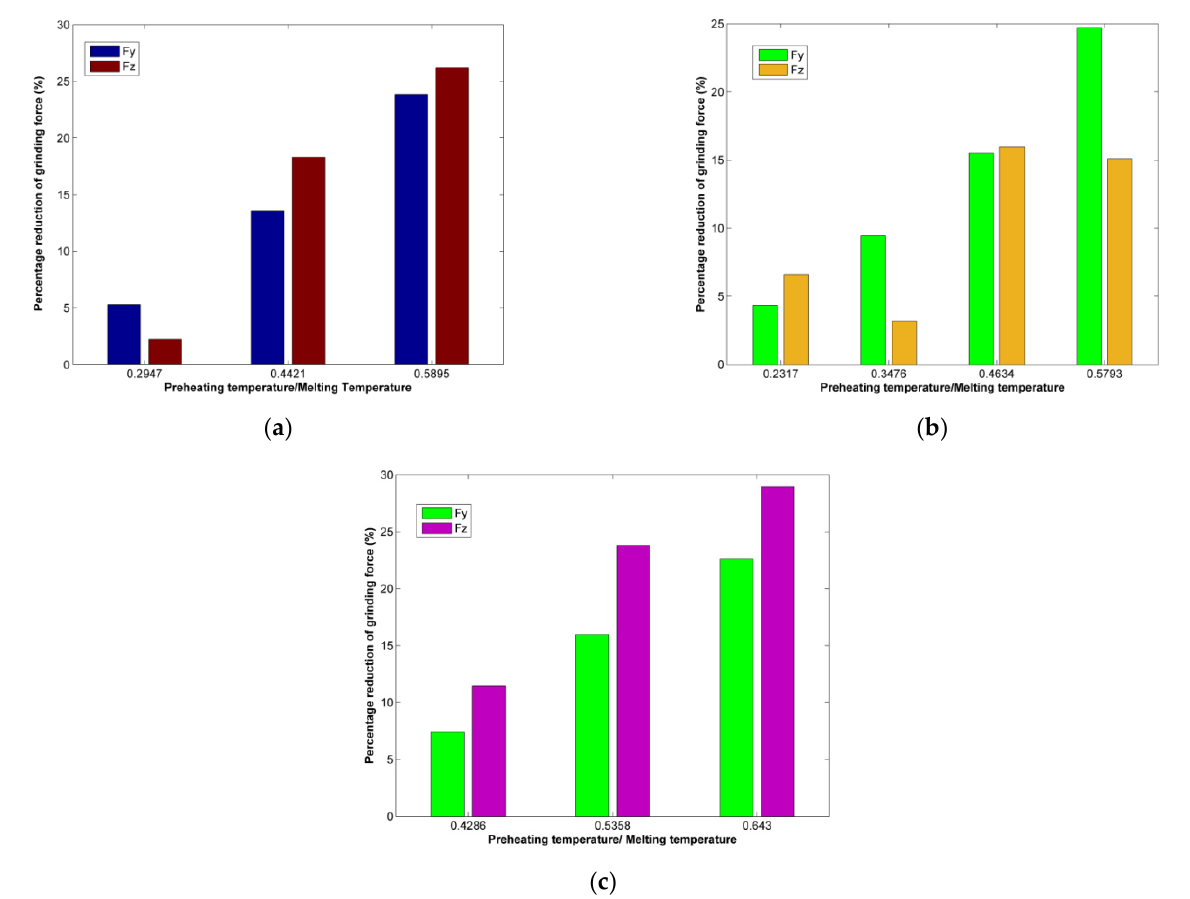
Figure 15. Percentage of grinding forces reduction at different preheating temperatures to melting temperature ratio values: ( a ) copper workpiece, ( b ) nickel workpiece, and ( c ) aluminum workpiece.